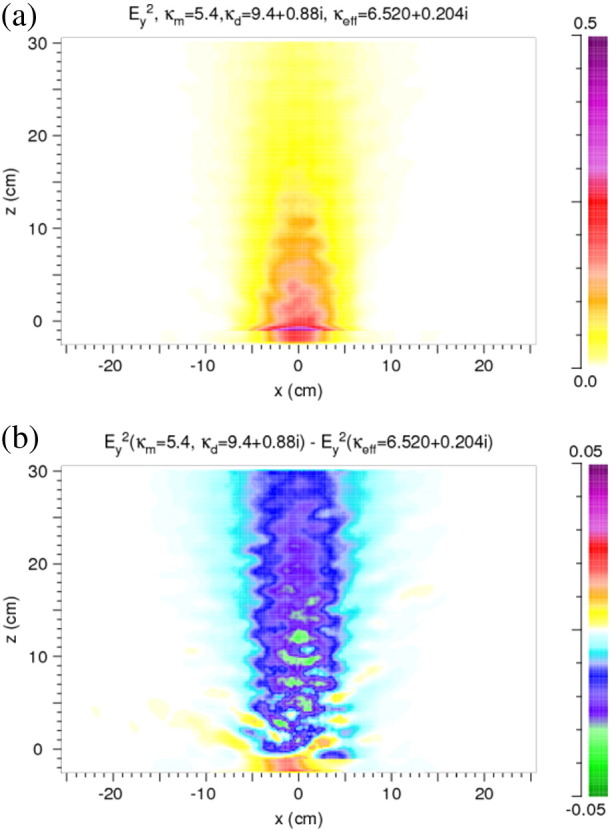
Ey2 (a) and ΔEy2 (b) for a larger difference of the real parts (κm,r = 5.4, and κd,r = 9.4) than in Fig. 5; κd,i = 0.88. In this case κeff is calculated from the other values (Eq. (4)).